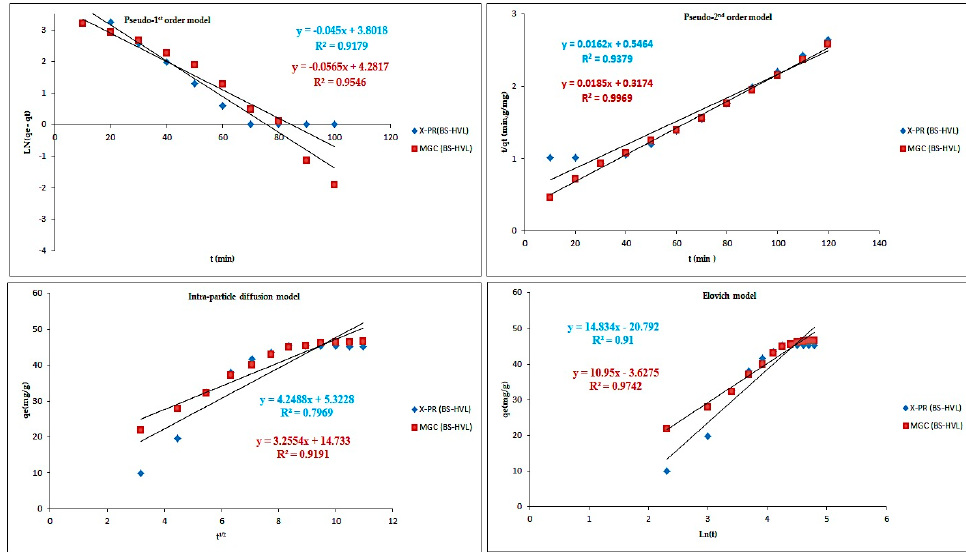
Figure 15. Kinetic models of the adsorption of the dyes X − PR and MGC by BS-HVL (T = 21 ± 1 °C; mad = 50 mg; Co = 50 mg L − 1 ; stirring speed 150 rpm and pH = 7 ± 0.3).